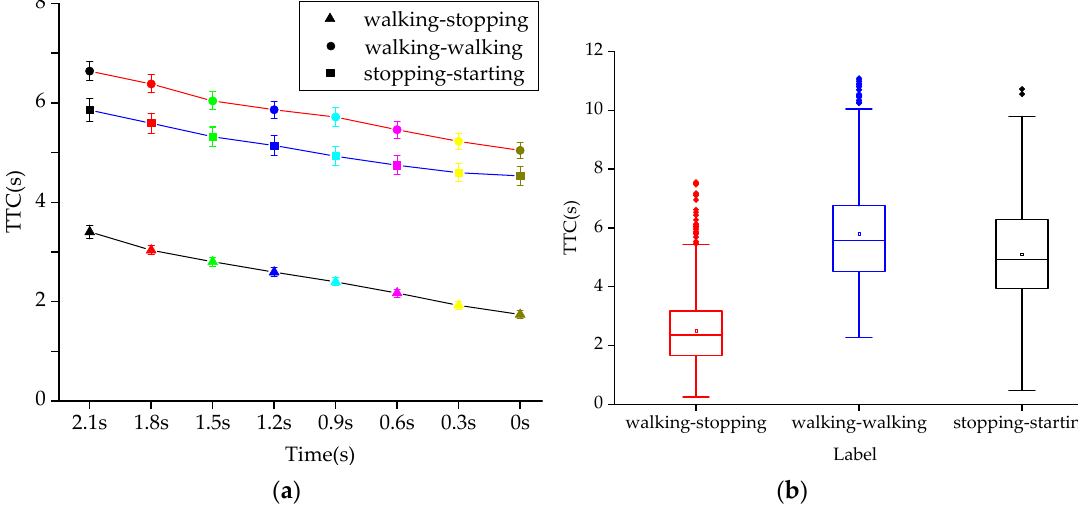
Figure 8. TTC diagram under different crossing intentions. ( a ) TTC at different times and with different intentions ( b ) TTC under different intentions.